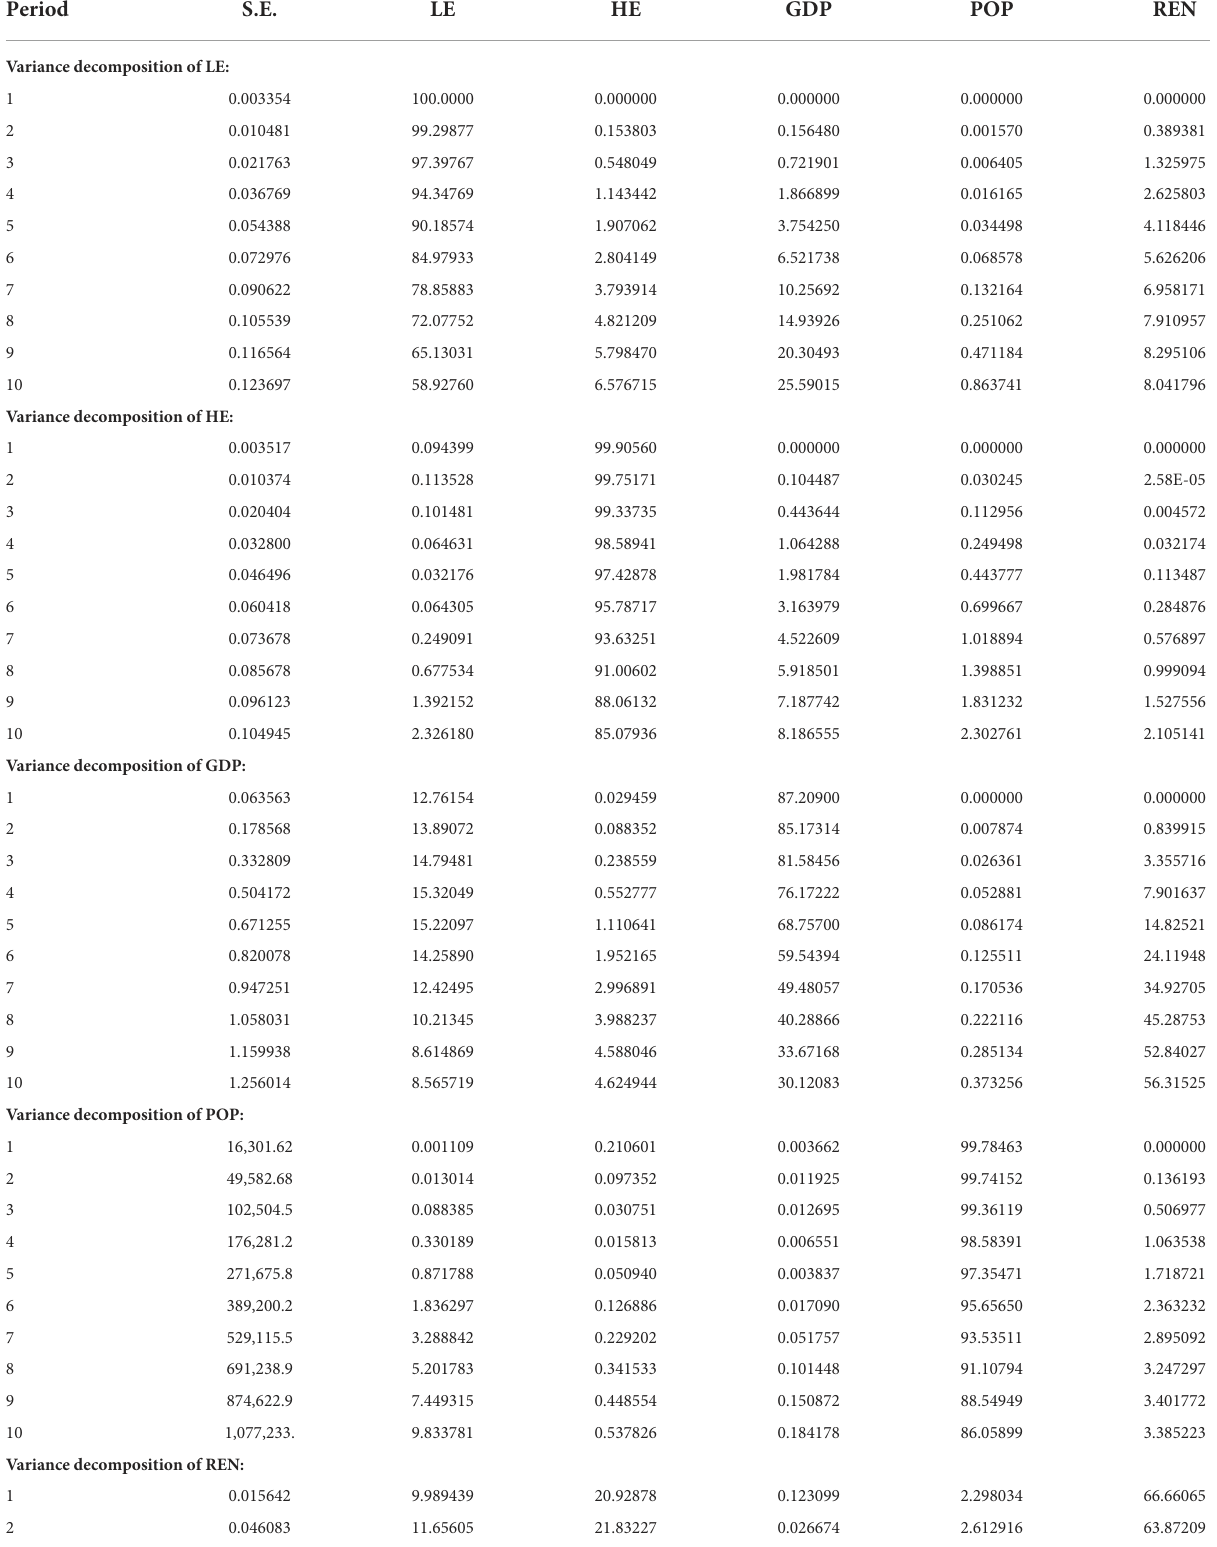
TABLE 4 Variance decomposition